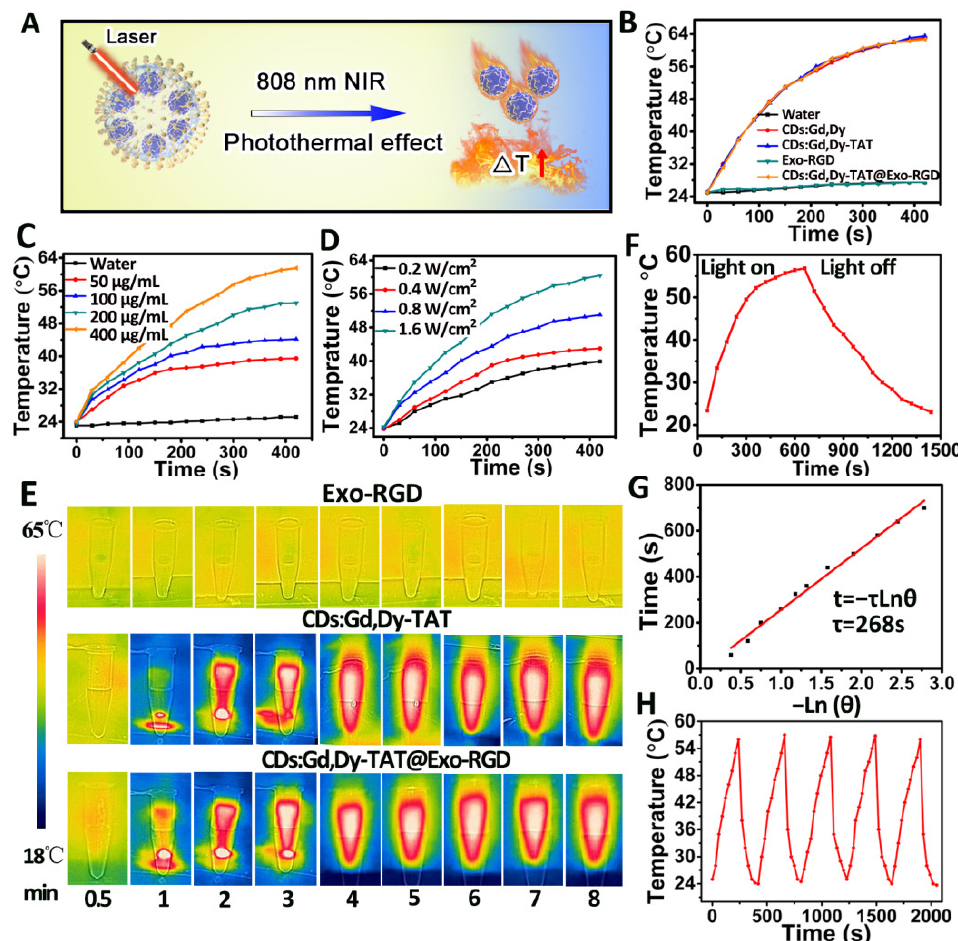
Figure 2. Photothermal conversion performance of CDs:Gd,Dy-TAT@Exo-RGD. ( A ) The schematic illustration of the photothermal effect triggered by NIR laser. ( B ) Temperature change curves of water, CDs:Gd,Dy, CDs:Gd,Dy-TAT, Exo-RGD and CDs:Gd,Dy-TAT@Exo-RGD under NIR laser irradiation (808 nm, 1.6 W · cm − 2 ). ( C ) Temperature change curves of CDs:Gd,Dy-TAT@Exo-RGD (50 µ g · mL − 1 , 100 µ g · mL − 1 , 200 µ g · mL − 1 , 400 µ g · mL − 1 ) under NIR laser irradiation (808 nm, 1.6 W · cm − 2 ). ( D ) Temperature change curves of CDs:Gd,Dy-TAT@Exo-RGD at different laser power densities (0.2, 0.4, 0.8, and 1.6 W · cm − 2 ). ( E ) Thermal infrared images of Exo-RGD, CDs:Gd,Dy-TAT and CDs:Gd,Dy-TAT@Exo-RGD aqueous solutions under NIR laser irradiation (808 nm, 1.6 W · cm − 2 ) at different time points. ( F ) Temperature change curve of CDs:Gd,Dy-TAT@Exo-RGD aqueous solution under NIR laser irradiation (808 nm, 1.6 W · cm − 2 ) with laser on and then off after 10 min. ( G ) Time constant of heat transferring measured by the time versus the negative natural logarithm of the temperature. ( H ) Temperature change curves of CDs:Gd,Dy-TAT@Exo-RGD solution under repeated (five times) on and off laser irradiation